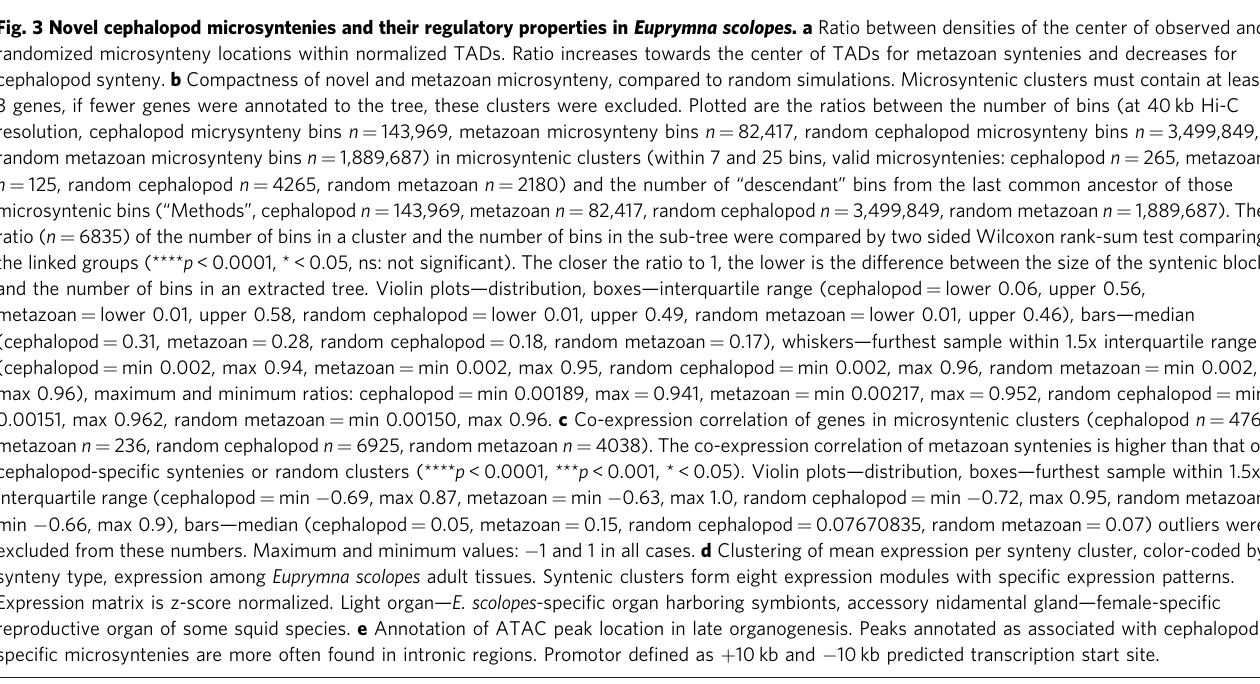
Fig. 3 Novel cephalopod microsyntenies and their regulatory properties in Euprymna scolopes . a Ratio between densities of the center of observed and randomized microsynteny locations within normalized TADs. Ratio increases towards the center of TADs for metazoan syntenies and decreases for cephalopod synteny. b Compactness of novel and metazoan microsynteny, compared to random simulations. Microsyntenic clusters must contain at least 3 genes, if fewer genes were annotated to the tree, these clusters were excluded. Plotted are the ratios between the number of bins (at 40 kb Hi-C resolution, cephalopod micrysynteny bins n = 143,969, metazoan microsynteny bins n = 82,417, random cephalopod microsynteny bins n = 3,499,849, random metazoan microsynteny bins n = 1,889,687) in microsyntenic clusters (within 7 and 25 bins, valid microsyntenies: cephalopod n = 265, metazoan n = 125, random cephalopod n = 4265, random metazoan n = 2180) and the number of “ descendant ” bins from the last common ancestor of those microsyntenic bins ( “ Methods ” , cephalopod n = 143,969, metazoan n = 82,417, random cephalopod n = 3,499,849, random metazoan n = 1,889,687).